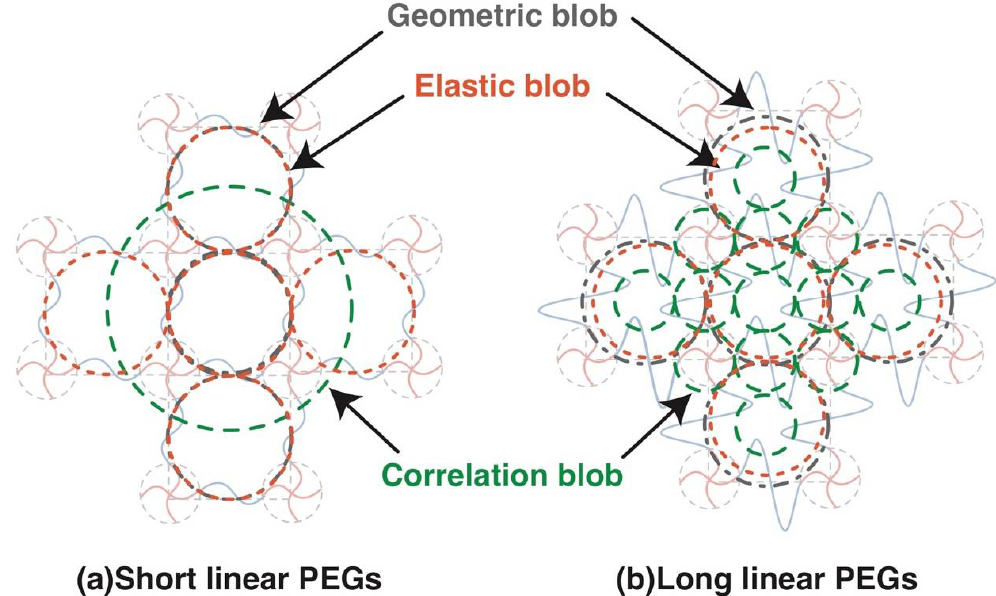
Figure 6. Schematic of various blobs in 2 × 4 gels in Case A complete network. ( a ) Network with short chains between crosslinkers; ( b ) Network with long chains between crosslinkers.